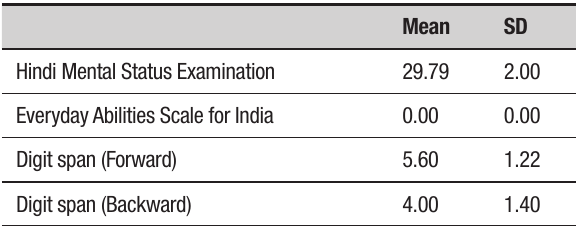
Table 2. Global cognitive score, everyday abilities and digit span in older adults: means and standard deviations